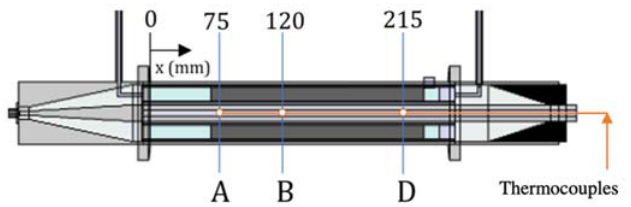
Figure 2. Locations of the thermocouples for the temperature measurement inside the inner con ‐ ductor.